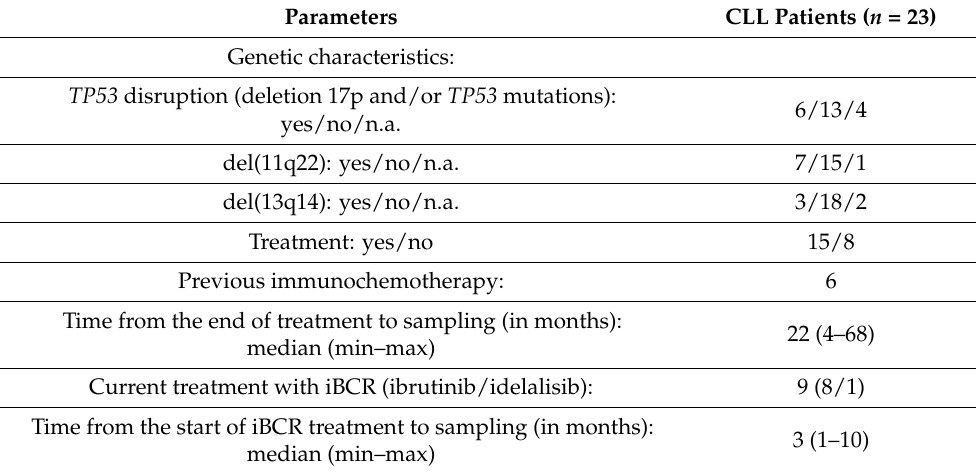
Table 1. Cont . Parameters CLL Patients ( n = 23) Genetic